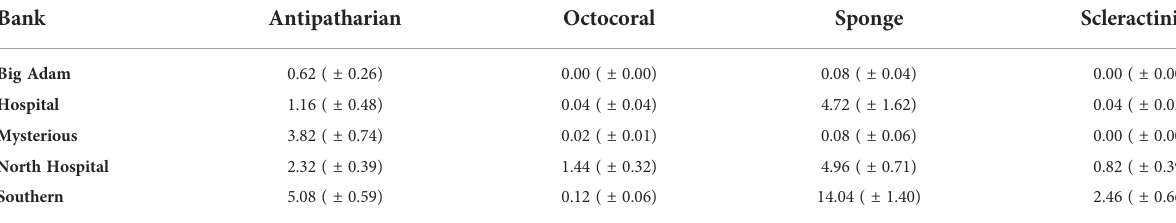
TABLE 2 Mean total percent cover (± SE) of target benthic groups found at the surveyed South Texas Banks.